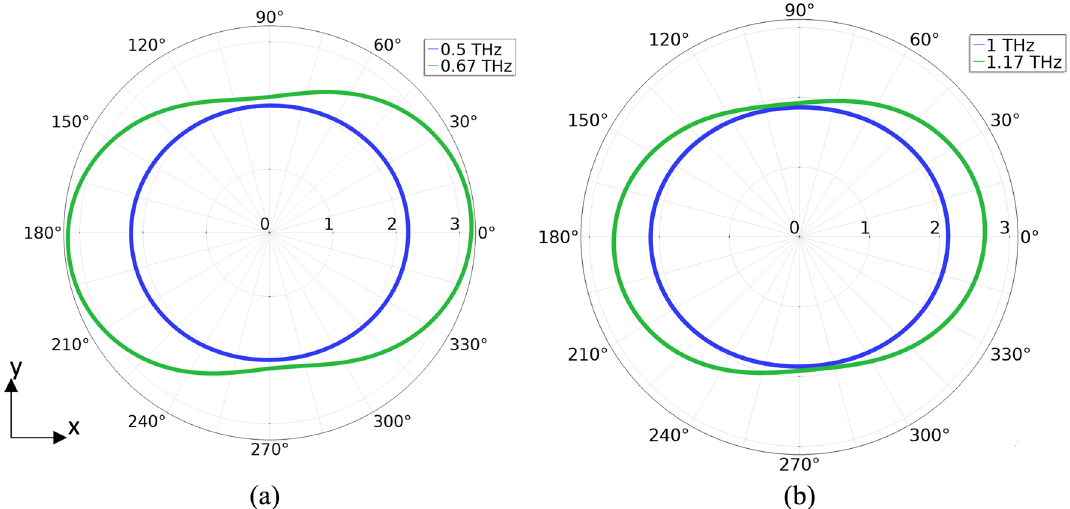
Figure 6. Simulated radiation patterns for the modified rotating dipole model (arbitrary scale) in the orbital plane. ( a ) Radiation pattern for the 0.5 THz system. The design frequency of 0.5 THz (blue) radiates uniformly in all directions in the plane of rotation. The peak frequency 0.67 THz (green) radiates in all directions in the orbital plane, but is more biased along the x-axis. ( b ) Radiation pattern for the 1 THz system. The design frequency of 1 THz (blue) radiates uniformly in all directions in the plane of rotation. The peak frequency of 1.17 THz radiates in all directions of the orbital plane, but is biased along the x-axis.